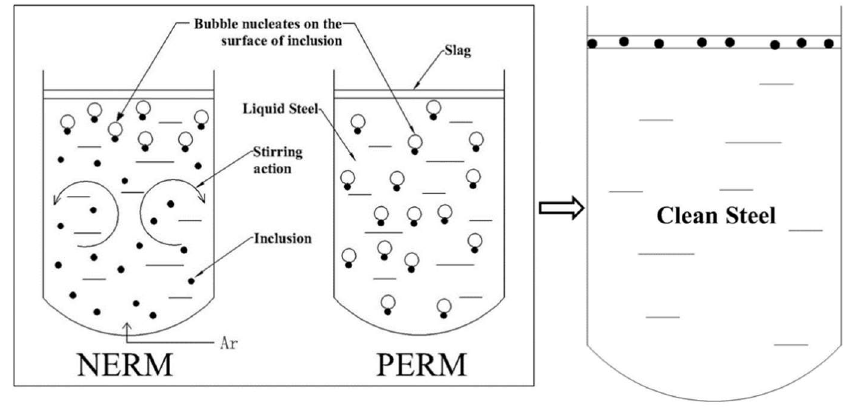
Figure 12. Comparison of mechanism of inclusion removal by NERM and PERM.